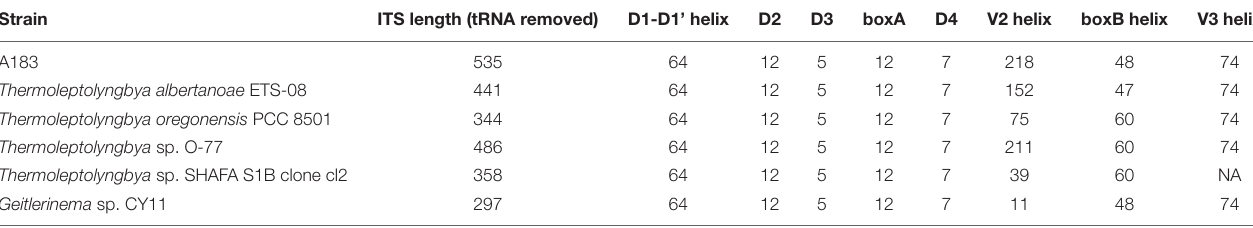
TABLE 4 | The length (bp) summary of regions within 16S-23S ITS of strains studied. Strain ITS length (tRNA removed) D1-D1’